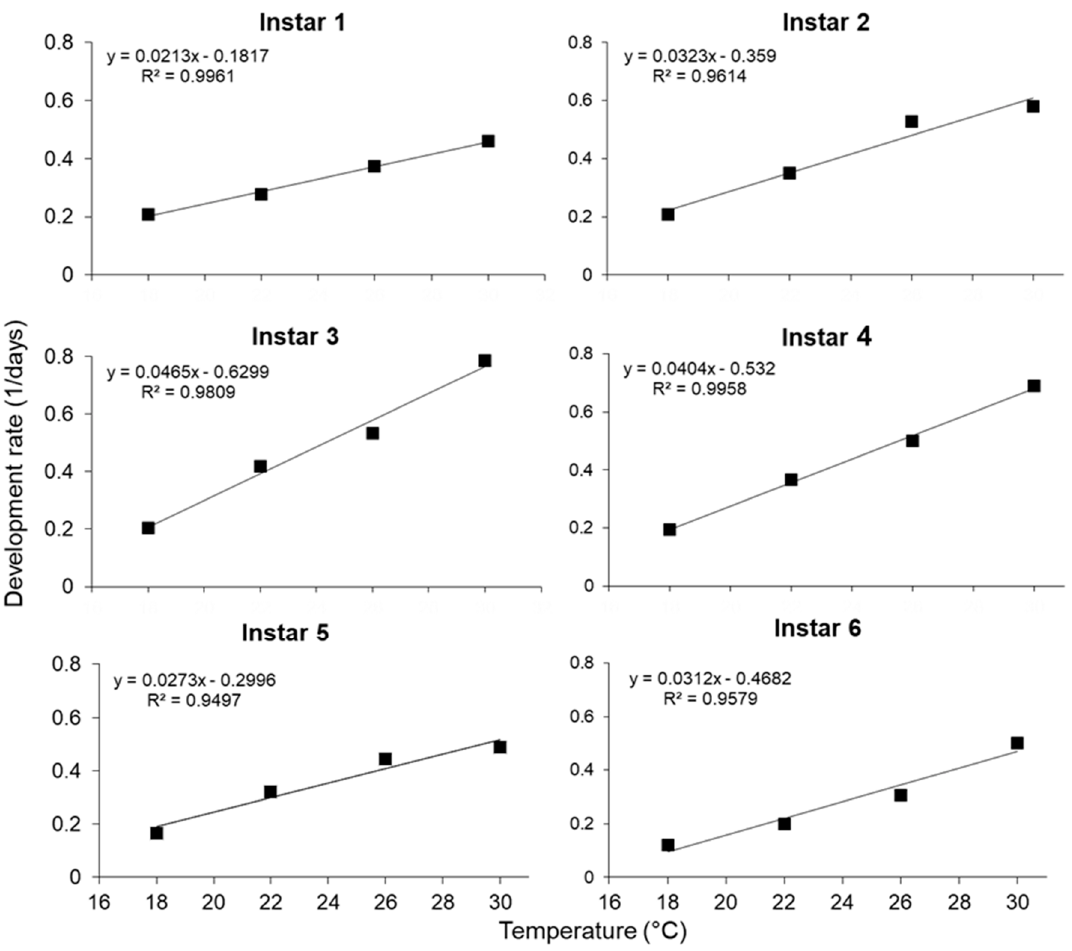
Figure 1. The relationships between Spodoptera frugiperda development rates and rearing temperature for larval instars one to six.